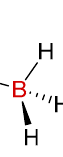
Figure 2. The monosubstituted borohydride salt, Na[H 3 B(mp)].